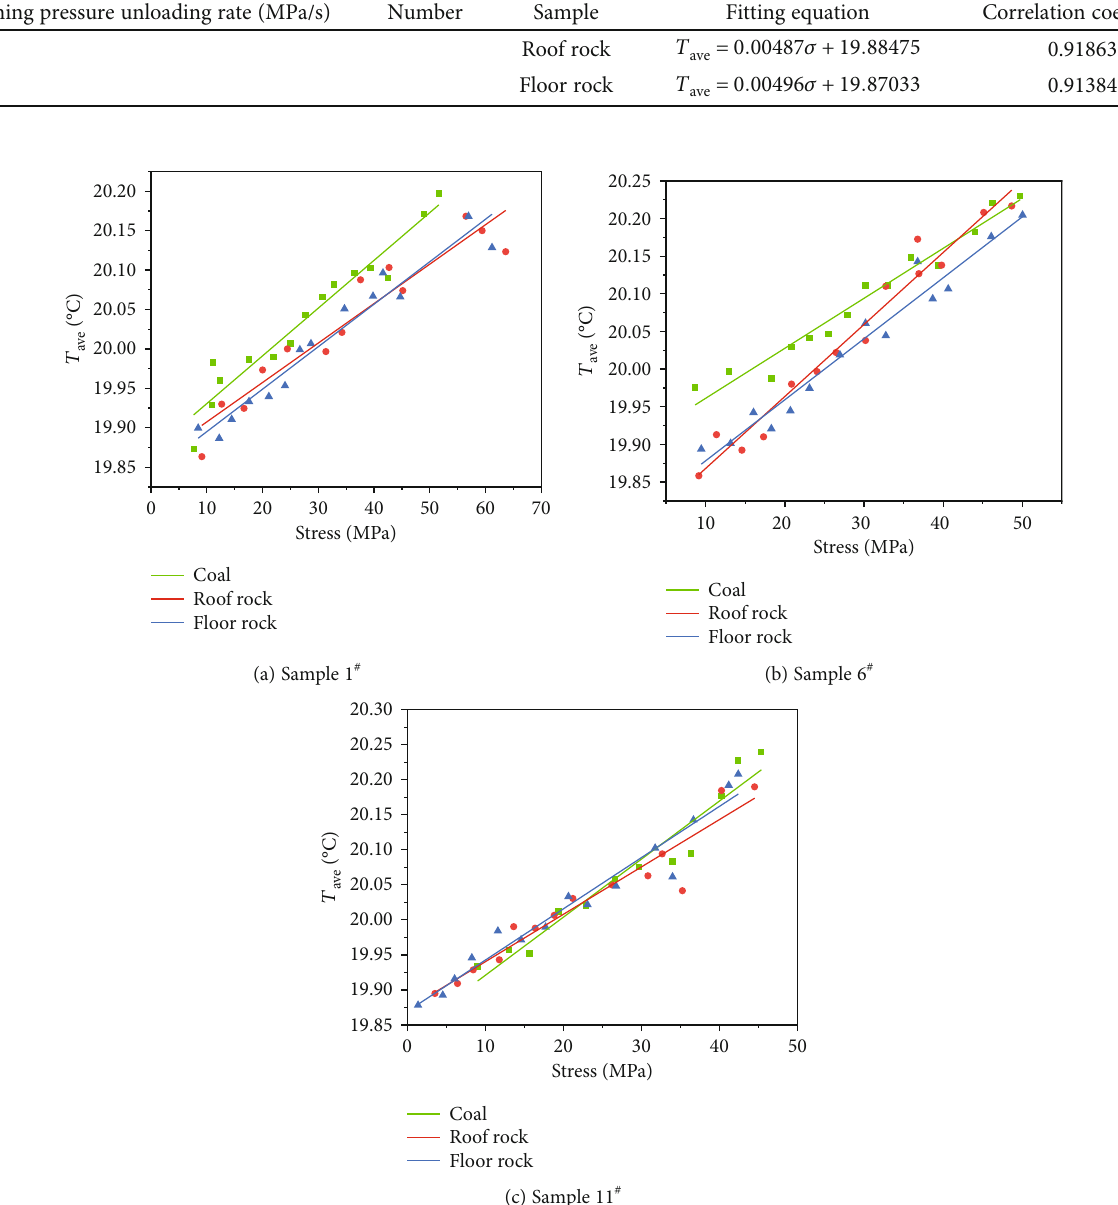
Figure 12: The experimental fi tting curve of thermal infrared radiation temperature and